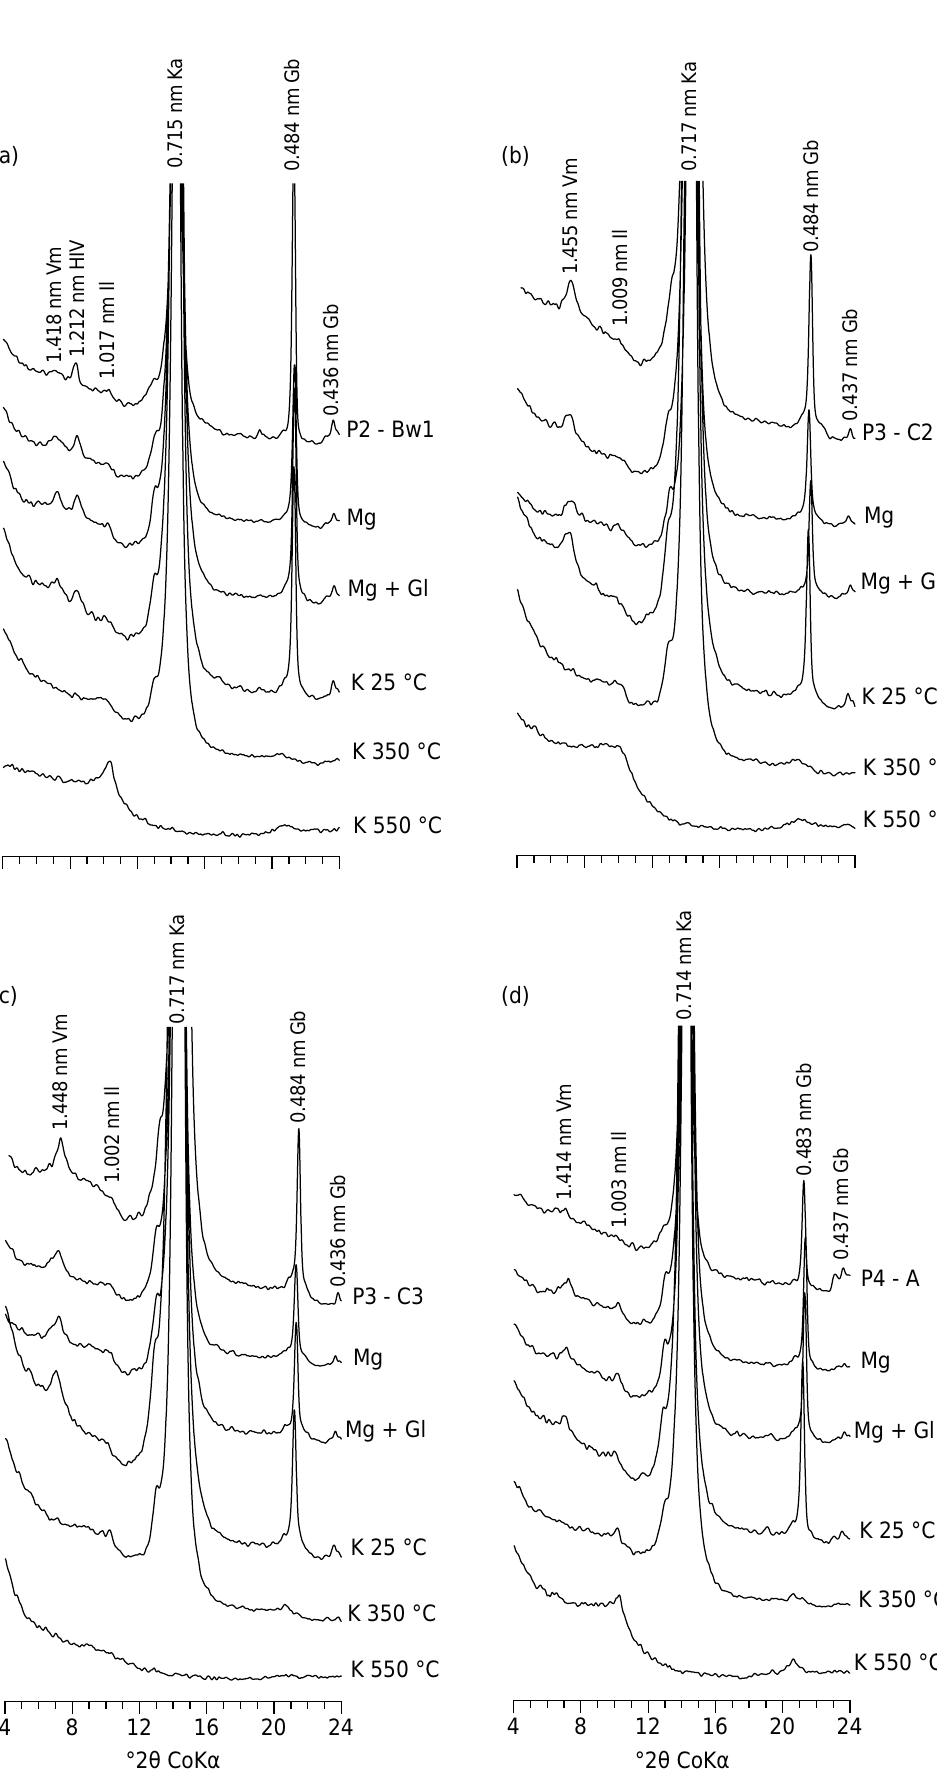
Figure 4. XRD patterns collected from Fe-free clay mineral (oriented powder) for identification of 2:1 minerals (Whittig and Allardice, 1986). (a) P2 - Hoz. Bw1; (b) P3 - Hoz. C2; (c) P3 - Hoz. C3; (d) P4 - Hoz. A. Vm = vermiculite; HIV = hydroxy-interlayered vermiculite; Ka = kaolinite; Gb =